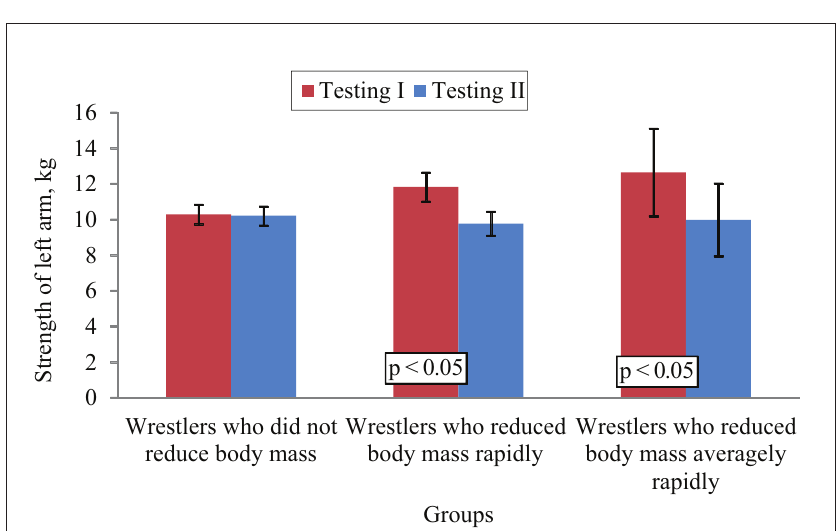
Figure 5. Wrestlers’ left arm force